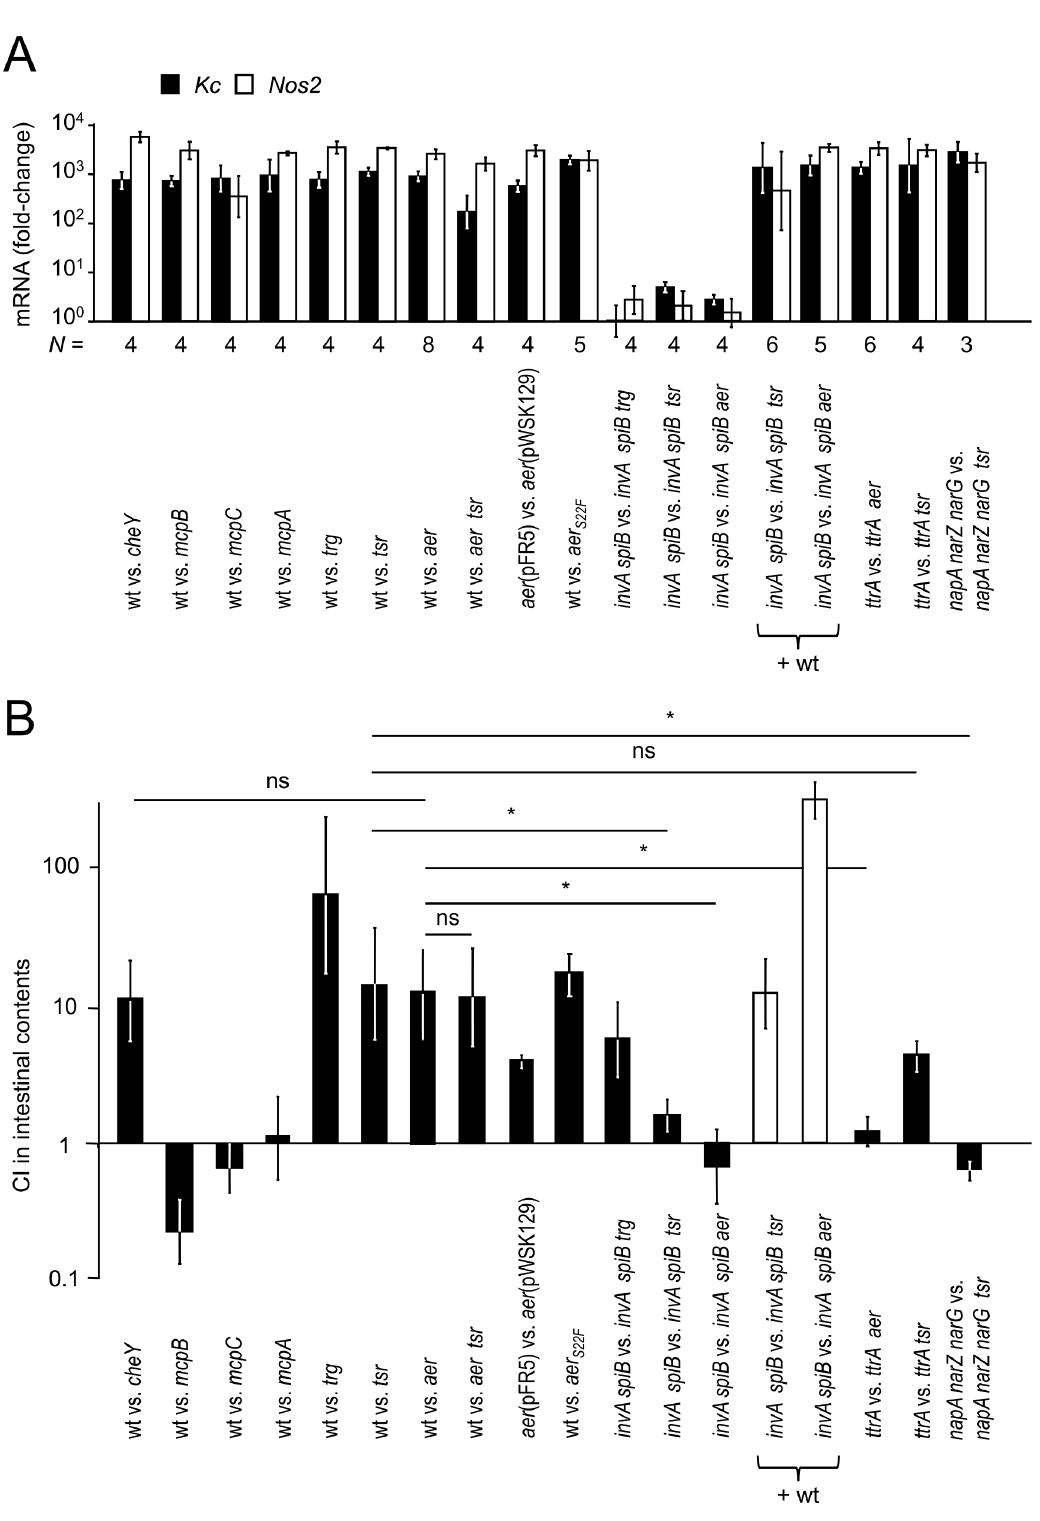
Figure 1. The aer and tsr genes confer a competitive growth advantage during colitis. Groups of streptomycin pre-treated mice ( N is indicated below the graph in panel A) were inoculated with equal mixtures of the indicated S . Typhimurium strains and organs were collected for analysis four days after infection. Mice were infected either with an equal mixture of two strains (black bars in panel B) or with an equal mixture of the S . Typhimurium wild type ( + wt) and two mutant strains (white bars in panel B). (A) Induction of transcripts encoding the inflammatory markers Kc (encoded by the Kc gene, black bars) and iNOS (encoded by the Nos2 gene, white bars) in the murine cecum after infection with the indicated mixtures of S. Typhimurium strains. Expression of Kc and Nos2 in the cecal mucosa was determined by quantitative real-time PCR analysis. Bars represent geometric means of Kc and Nos2 mRNA copy numbers as fold-change over mRNA levels in mock-infected mice 6 standard error. (B) Competitive indices (CI) of S . Typhimurium strains recovered from the colon contents of infected mice. Bars represent geometric means 6 standard error. *, P , 0.05; ns, not significant. doi:10.1371/journal.ppat.1003267.g001 PLOS Pathogens |